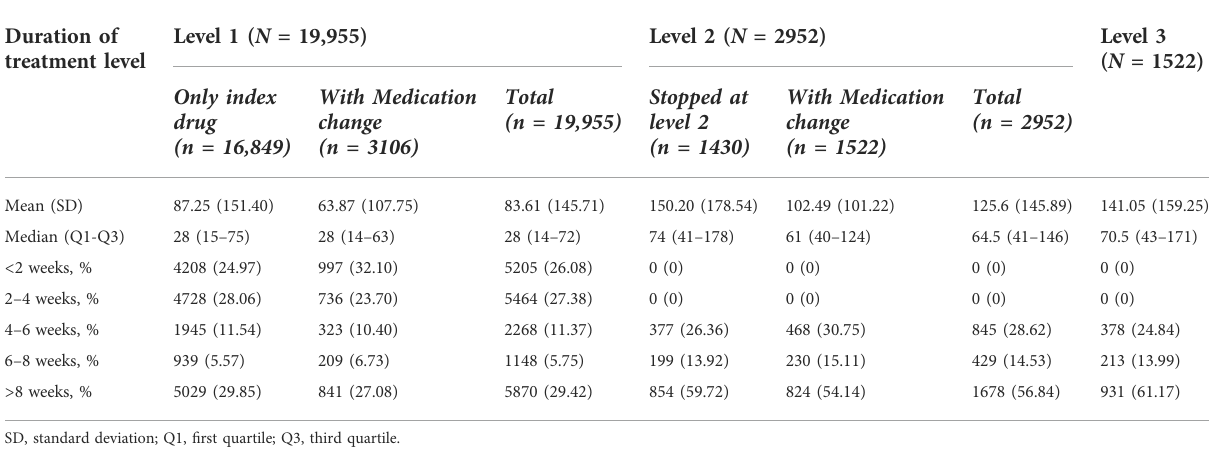
TABLE 3 Duration of treatment levels of study patients.